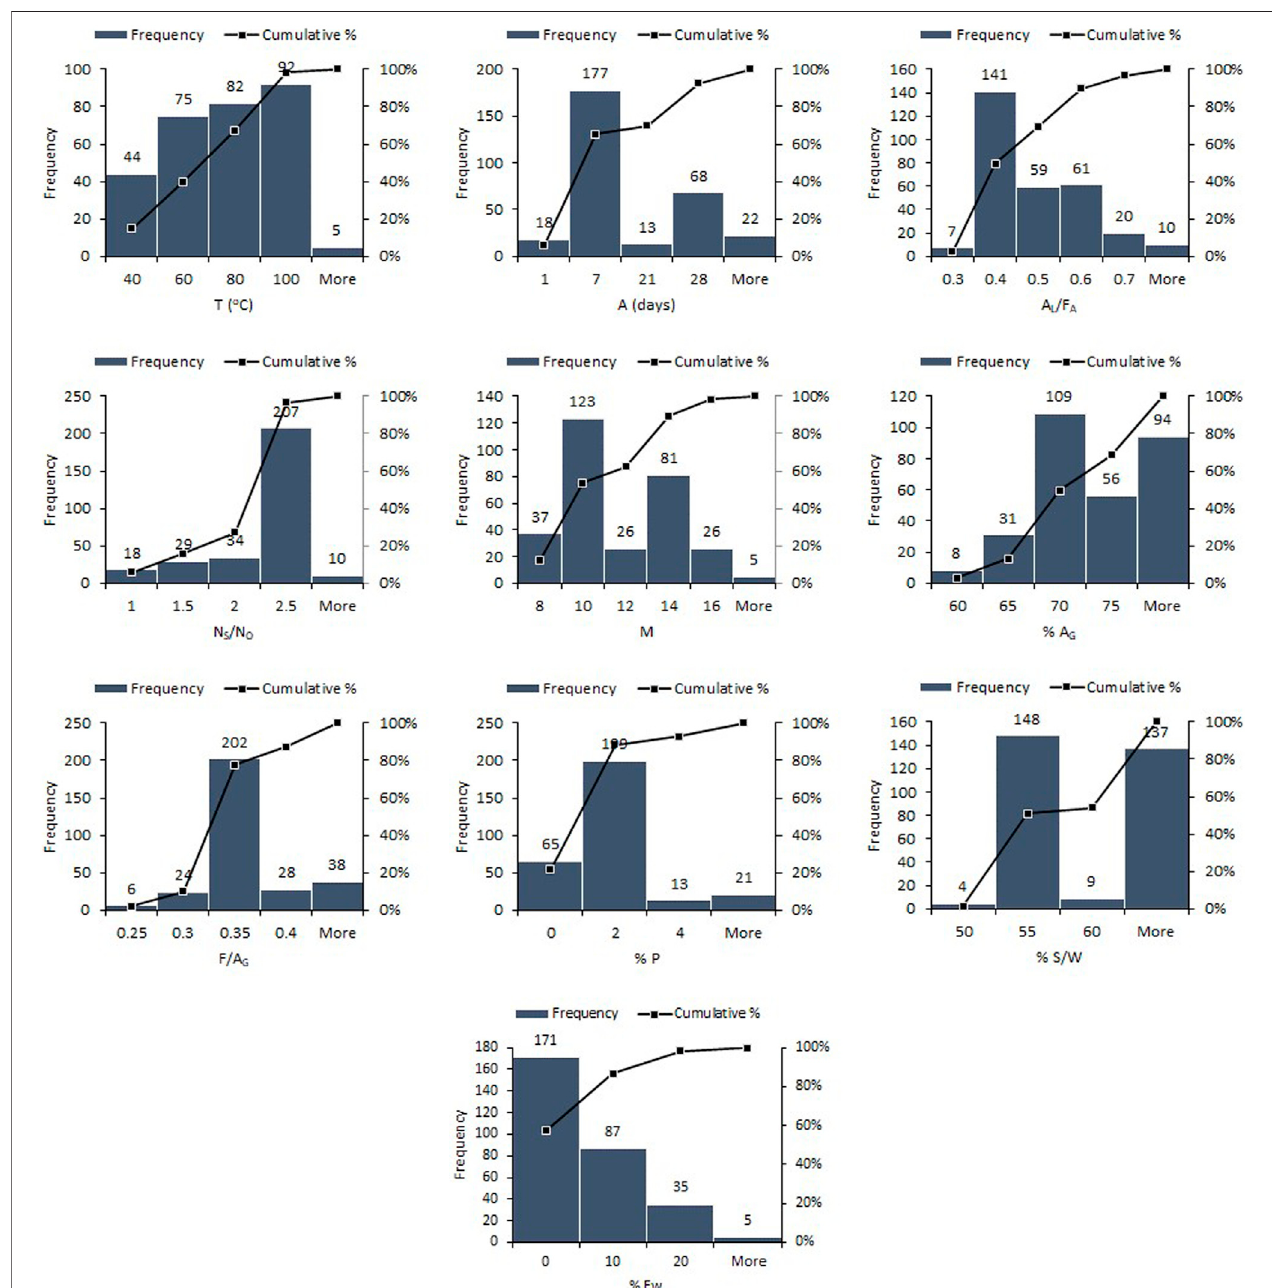
FIGURE 3 | Occurrence frequency and cumulative percentage of explanatory